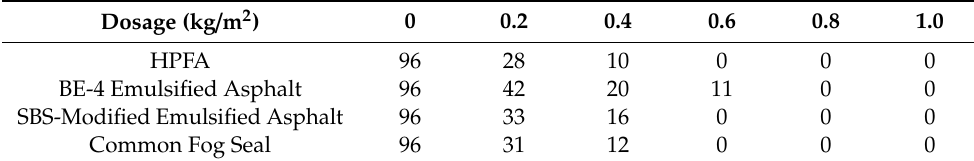
15 of 19 Figure 18. Skid resistance performance of different fog seals: ( a ) HPFA; ( b ) SBS-modified emulsified asphalt; ( c ) common fog seal; ( d ) BE-4 emulsified asphalt. The amount of skid resistance fog seal had a better skid resistance performance at 0.5–0.7 kg/m 2 . The skid resistance performance was still better than that of the other fog seals as the number of wear times increased. After 100,000 instances of abrasion, the skid resistance was greater than 50 BPN when the amount of the HPFA skid resistance seal was 0.6 kg/m 2 . This result indicated a good skid resistance performance. •